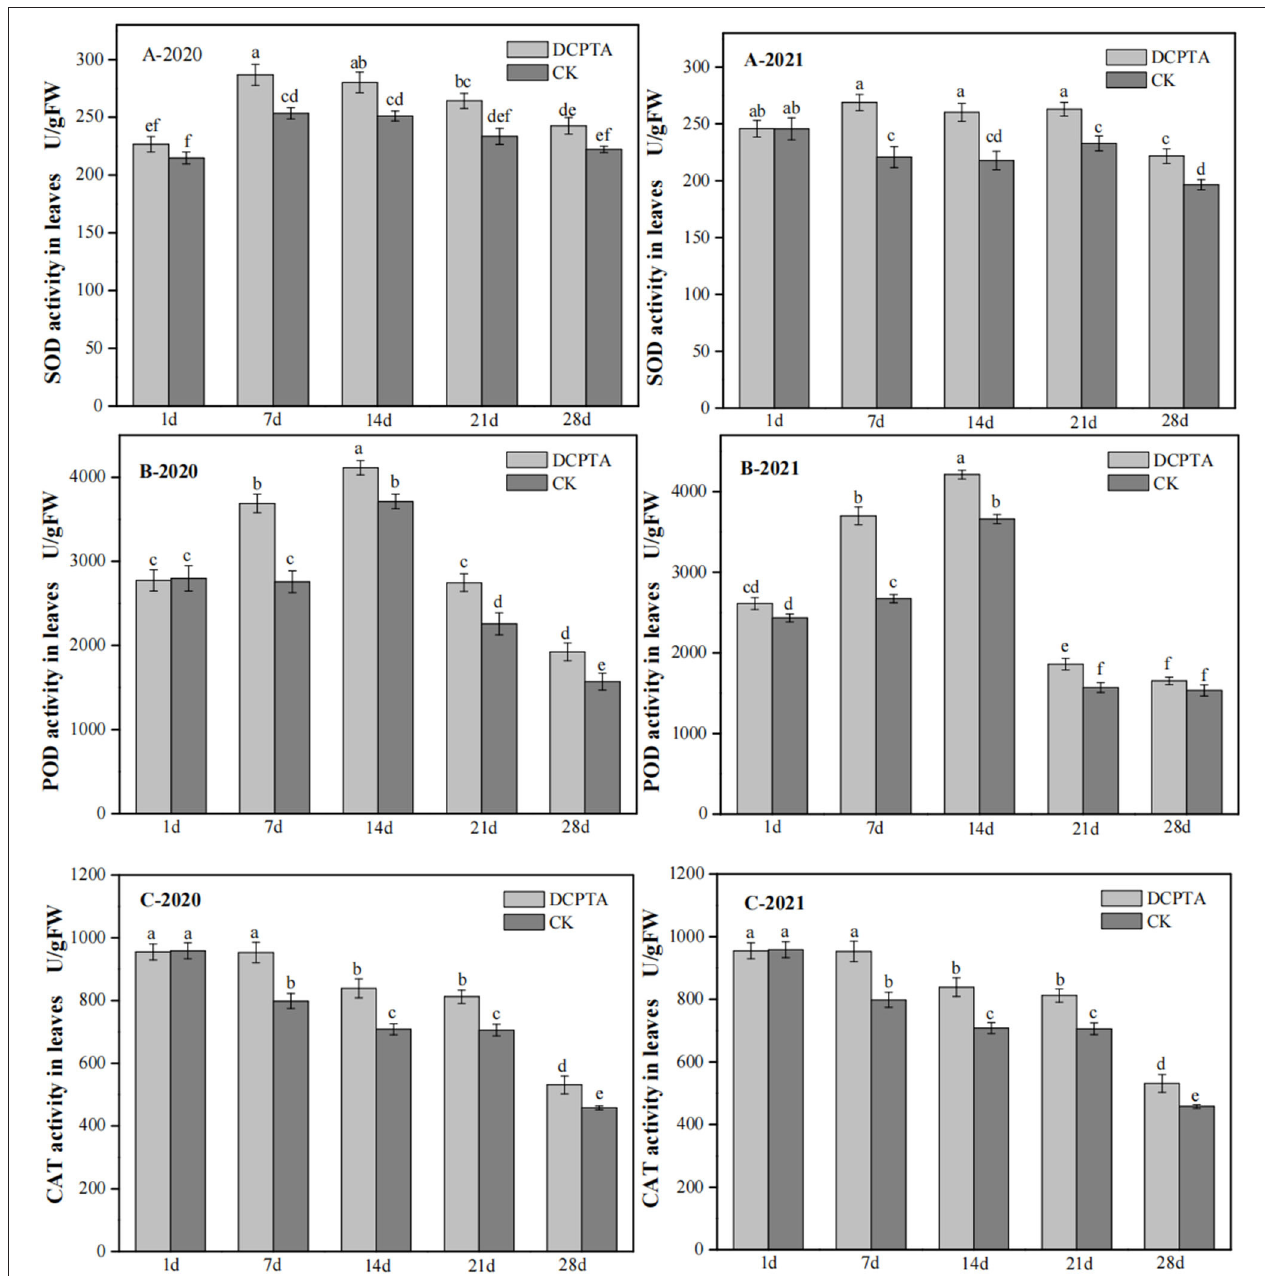
FIGURE 3 | The effect of SOD, POD, and CAT activity in leaves on days after spraying from 2020 to 2021. (A) SOD activity; (B) POD activity; and (C) CAT activity in leaves at 1–28 days after spraying in 2020 and 2021. Data were analyzed by ANOVA to separate significance. Vertical bars represent mean ± SE from three independent replicates and the different letters denote significant differences ( p <